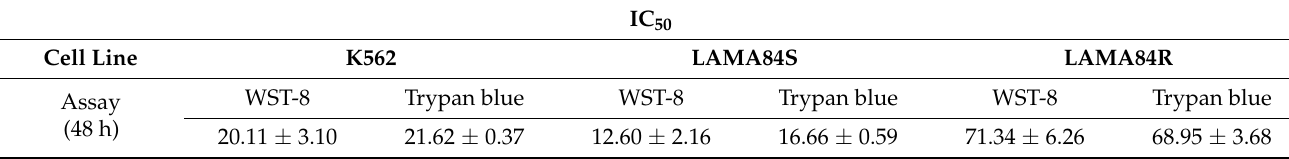
Table 1. IC 50 of K562, LAMA84S, and LAMA84R cell lines upon curcumin treatment evaluated through WST-8 cell viability and trypan blue exclusion assays at 48